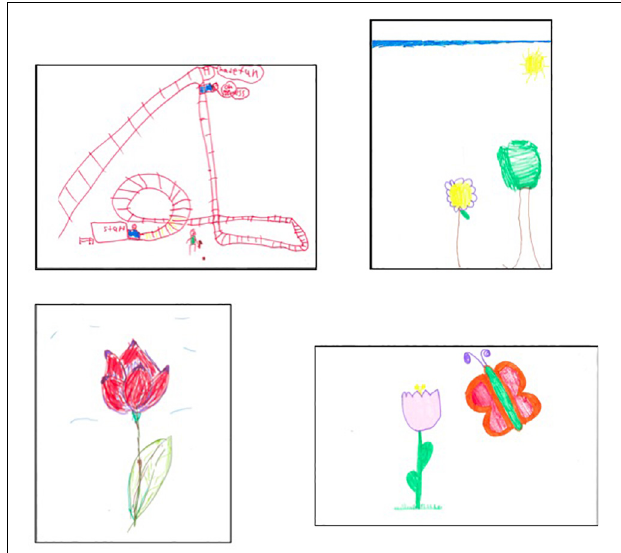
FIGURE 3 | Study 3 sample of children’s drawings. Younger children drew activities they enjoyed (top, left) and items they felt competent drawing (top, right) . Older children drew items they observed (bottom, left) or had thought of (bottom, right) .